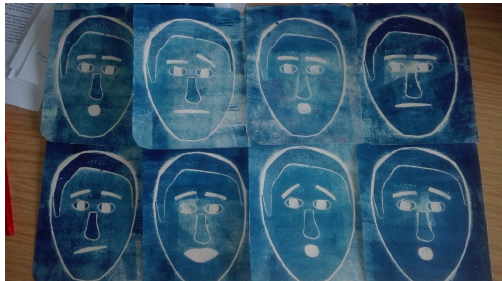
Figure 2. A print produced by one participant. The diary caption underneath read “Communicator”. This example is illustrative of the ways in which some participants used different art forms to re- flect on their professional roles (JA). Photograph: Josh